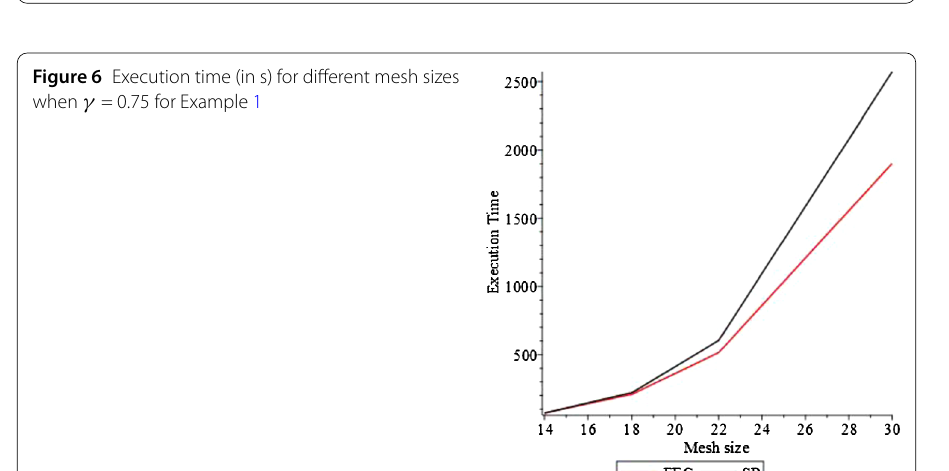
Figure 6 Execution time (in s) for different mesh sizes when γ = 0.75 for Example 1